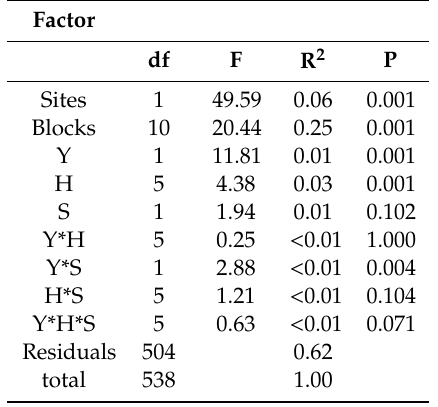
Table 2. Results of PERMANOVA tests on the e ff ects of time (year: Y), herbicide treatment (H), seeding treatment (S), and their interactions on Bray–Curtis dissimilarities among plots across all sites. Sites and blocks were included in the analysis as separate main e ff ects without